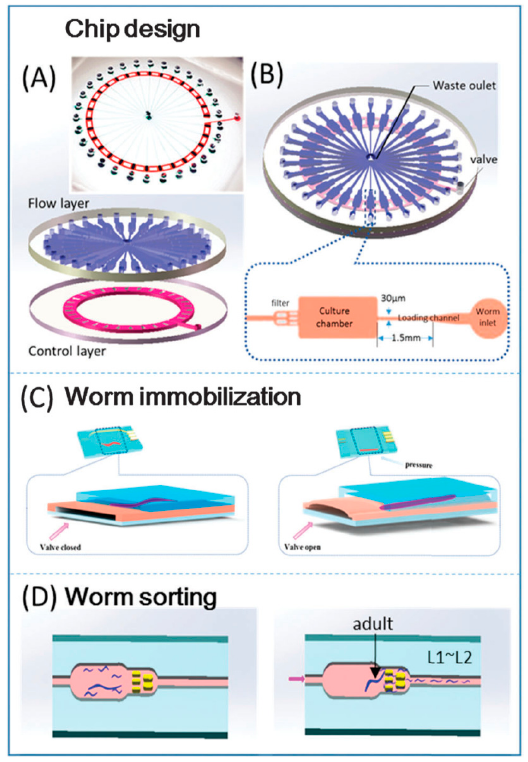
Figure 7. ( A , B ) The chip design developed by Zhu et al. [43] and the various layers and structures in the chip; ( C ) the methodology of worm immobilization via deformation of the bottom, control layer; ( D ) the methodology for separating young worms from the adult worm under observation. Reprinted with permission from the Royal Society of Chemistry.